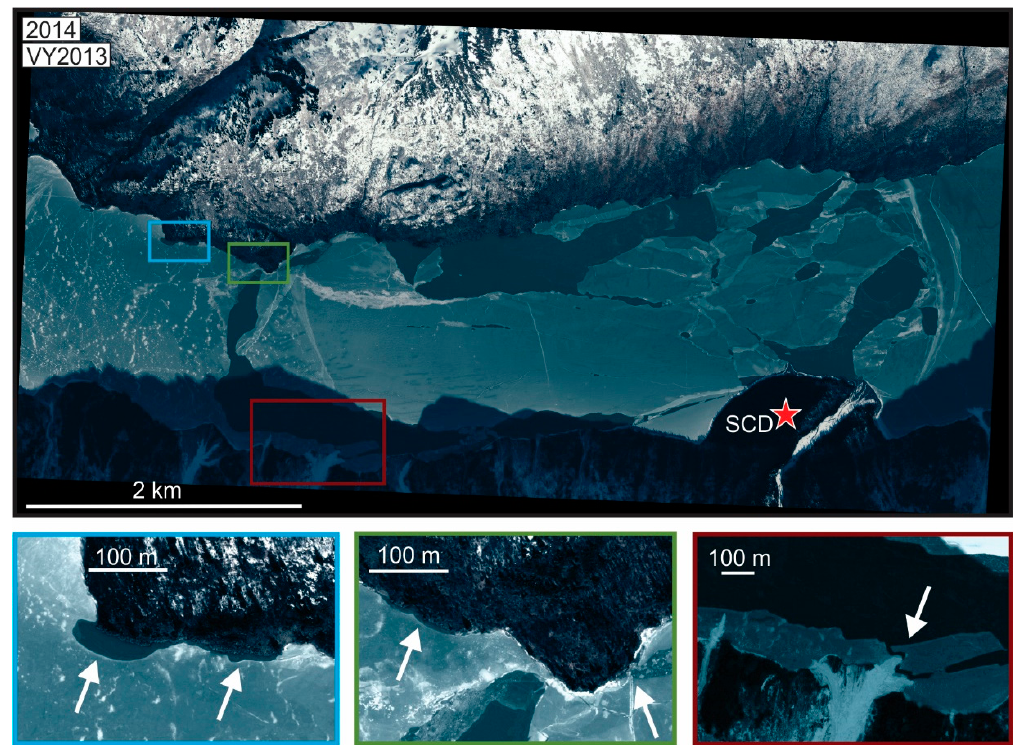
Figure 3. March 23, 2014. Top: Satellite image of the central basin of Kenai Lake. The Ship Creek Delta (SCD) is indicated with a red star as a reference point. Two snow-avalanche deposits occurred in the western part of the central basin with little to no debris visible. Bottom: Magnified images of the observed snow-avalanche deposits and ice melting along the north shore. Melting was followed by the growth of cracks in the ice and finally cracked ice pans that floated around in the lake. Such cracks were also observed along the border of the eastern avalanche deposits.